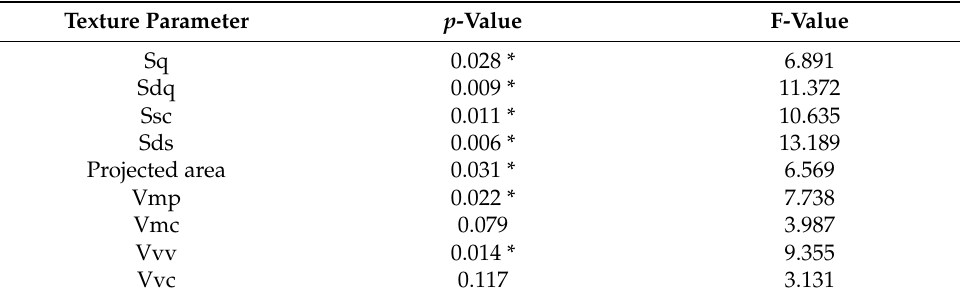
Table 1. Results of one-way ANOVA for different texture parameters. Texture Parameter p